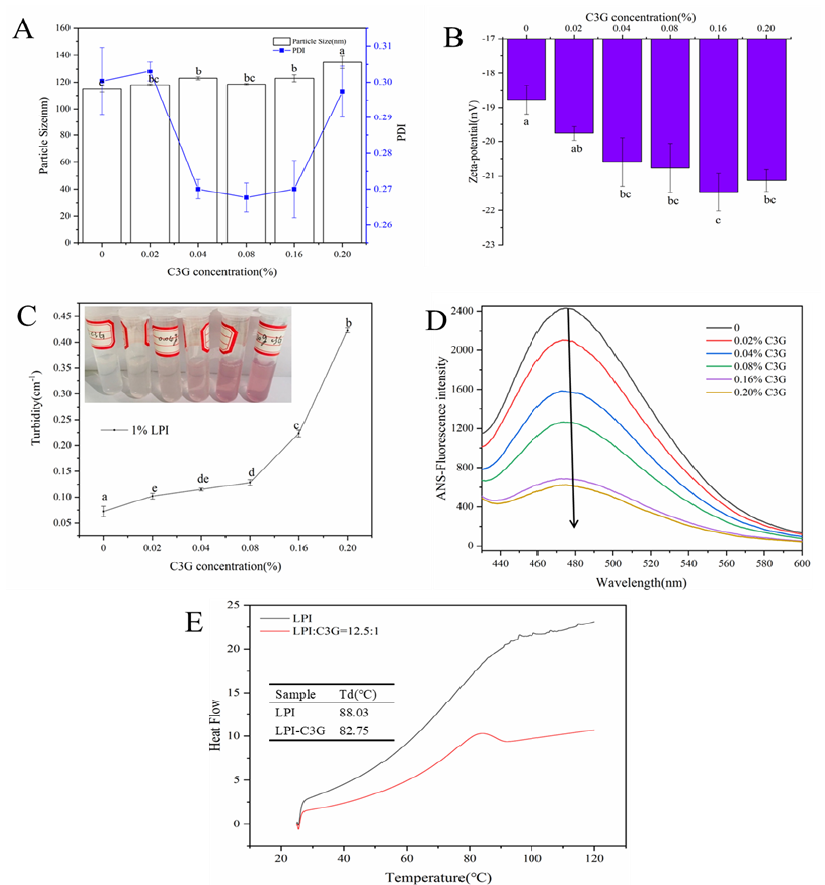
Figure 1. Particle size and PDI ( A ), zeta potential ( B ), and turbidity ( C ) of LPI-C3G complexes at different C3G concentrations; ANS-fluorescence intensity ( D ) and thermal denaturation tempera- tures ( E ) of LPI-C3G complexes (0.5 mg/mL LPI). Different letters represent significant differences ( p < 0.05).